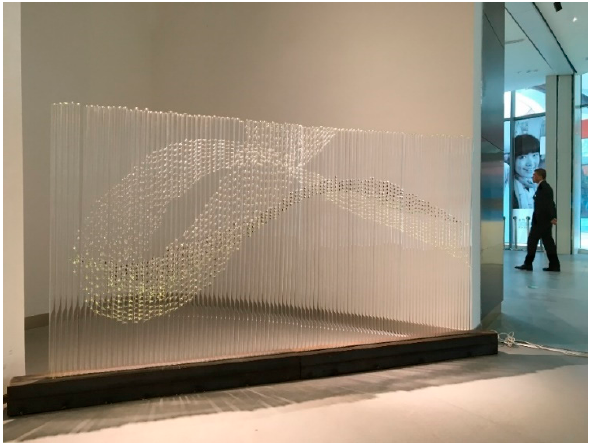
Figure 11. Murmuration no. 3 (2017) by Ayako Tani.